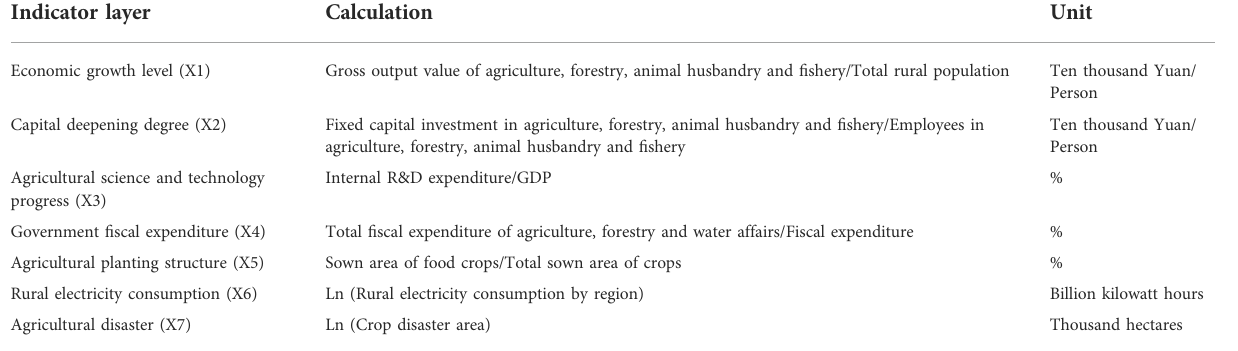
TABLE 3 Indicators of in fl uencing factors of